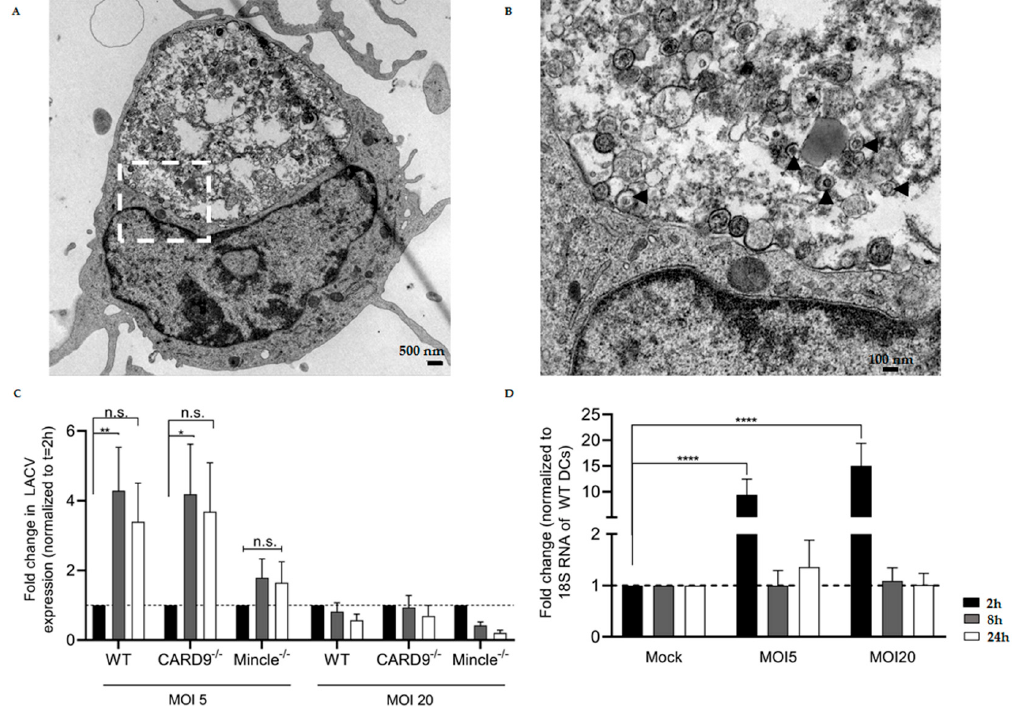
Figure 3. LACV internalization, replication in Mincle − / − , CARD9 − / − , or WT dendritic cells (DCs), and LACV-dependent induction of Mincle expression. ( A ) Transmission electron microscopy (TEM) picture showing a LACV-infected WT DC at time 2 h (magnification 6300 × ). ( B ) Close-up TEM picture (magnification 25,000 × ) of highlighted region in (A). The black arrowheads show LACV particles inside vesicles in the phagolysosome. ( C ) Expression levels of LACV N mRNA at different time points in DCs. The time point 2 h was used as baseline (internalized LACV). In C, two distinct LACV MOI were used—MOI 5 and MOI 20. ( D ) Expression levels of Mincle mRNA at different time points in LACV-infected WT DCs. The mock-infected DCs were used as baseline. Data shown in (C) and (D) are mean ± SEM and three independent experiments were performed. A two-way ANOVA with a Tukey’s honest significance test was used to compare differences between the different groups and p < 0.05 was considered significant (* p < 0.05, ** p < 0.01, *** p < 0.001, **** p < 0.0001).